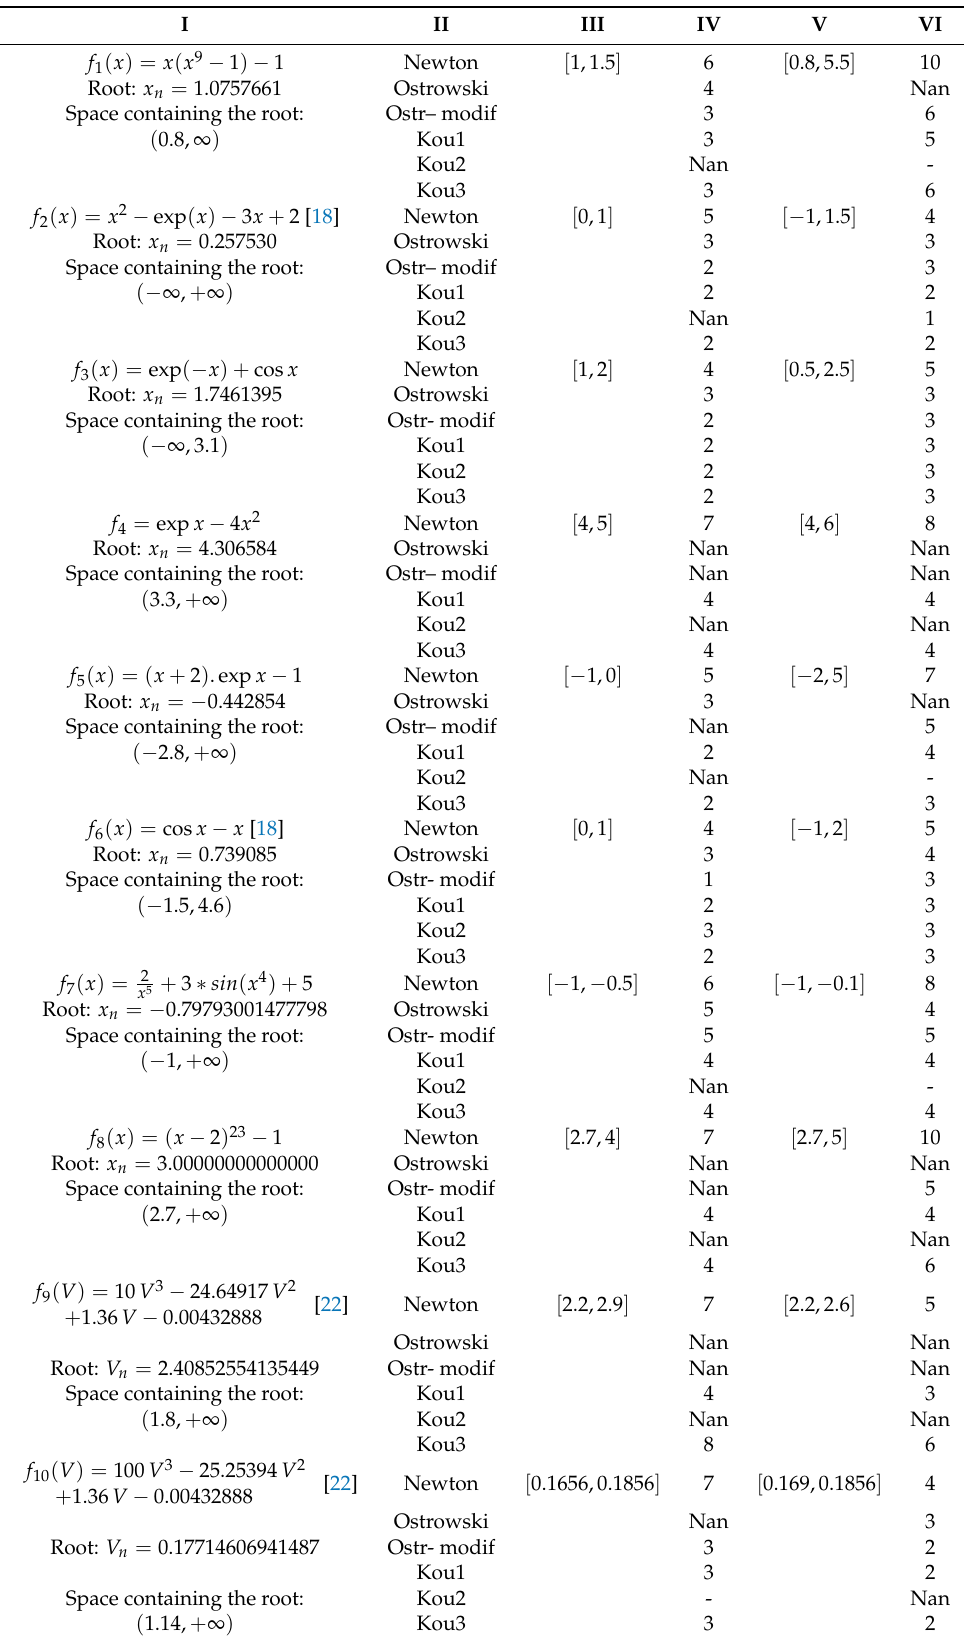
Table 1. Experiments with some